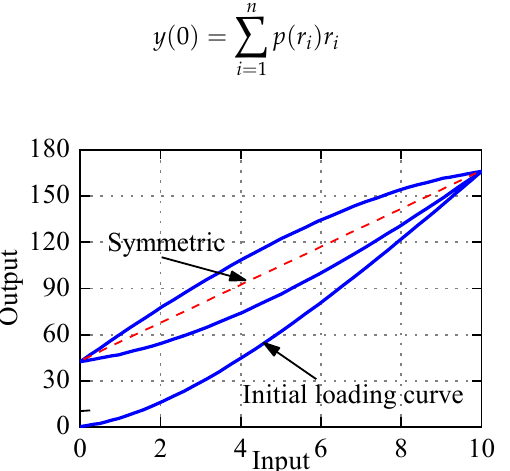
Figure 3. Hysteresis loops generated by the Prandtl–Ishlinskii (PI) model.